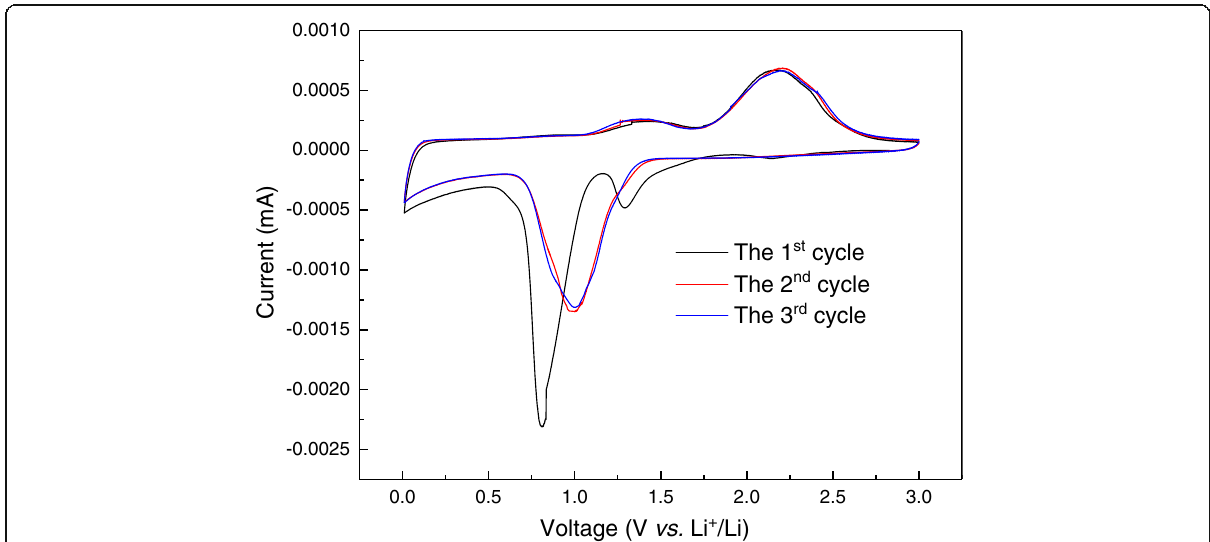
Fig. 7 Cyclic voltammetry (CV) analysis of sea urchin-like NiCo 2 O 4 anodes in the voltage range of 0.005 – 3.0 V with a scanning rate of 0.01 mV s − 1